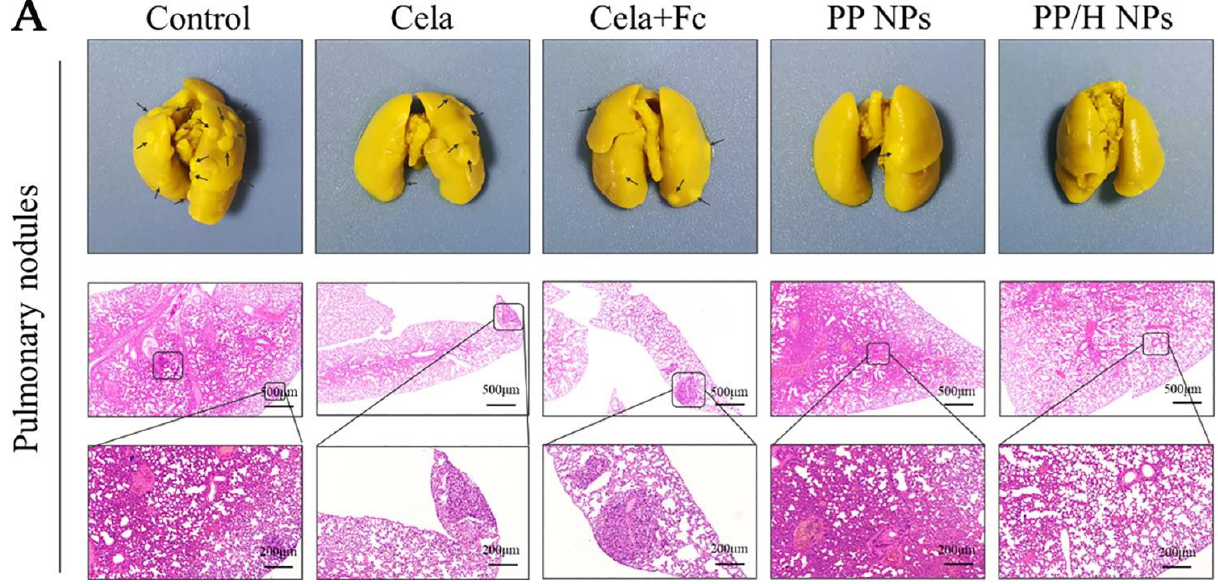
Figure 5. Observation of pulmonary metastasis after administration of different formulations ana- lyzed by H&E staining. A looser tissue was observed in mice lung treated with PP/H compared to the others with no dense staining. Reproduced with permission from reference [174].